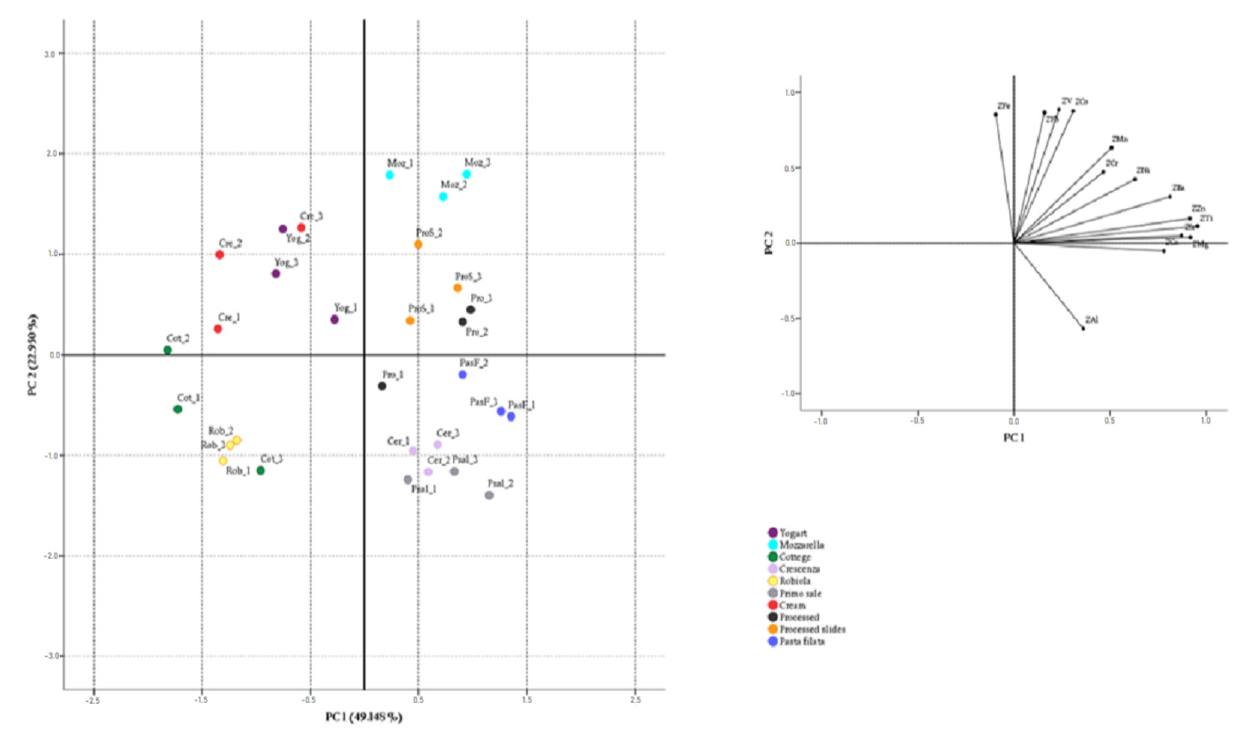
Figure 1. PCA for delactosed dairy samples. Inserts: loadings plot for PC1 and PC2.